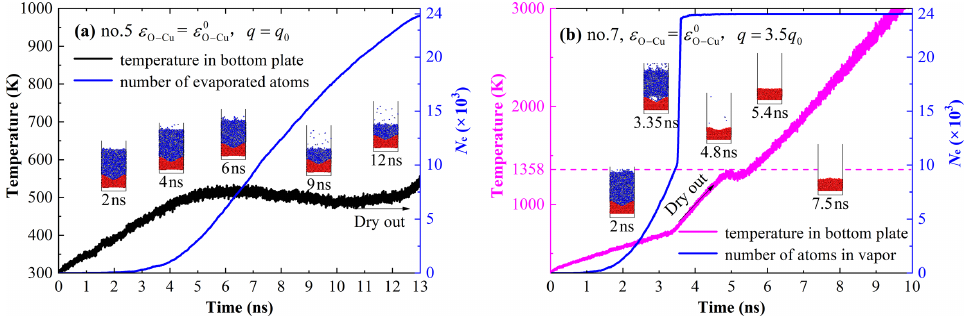
Figure 4. Temporal variations in temperatures in the bottom plates and the evaporated atom numbers for cases ( a ) no. 5 (Surface − 1, (cid:101) 0